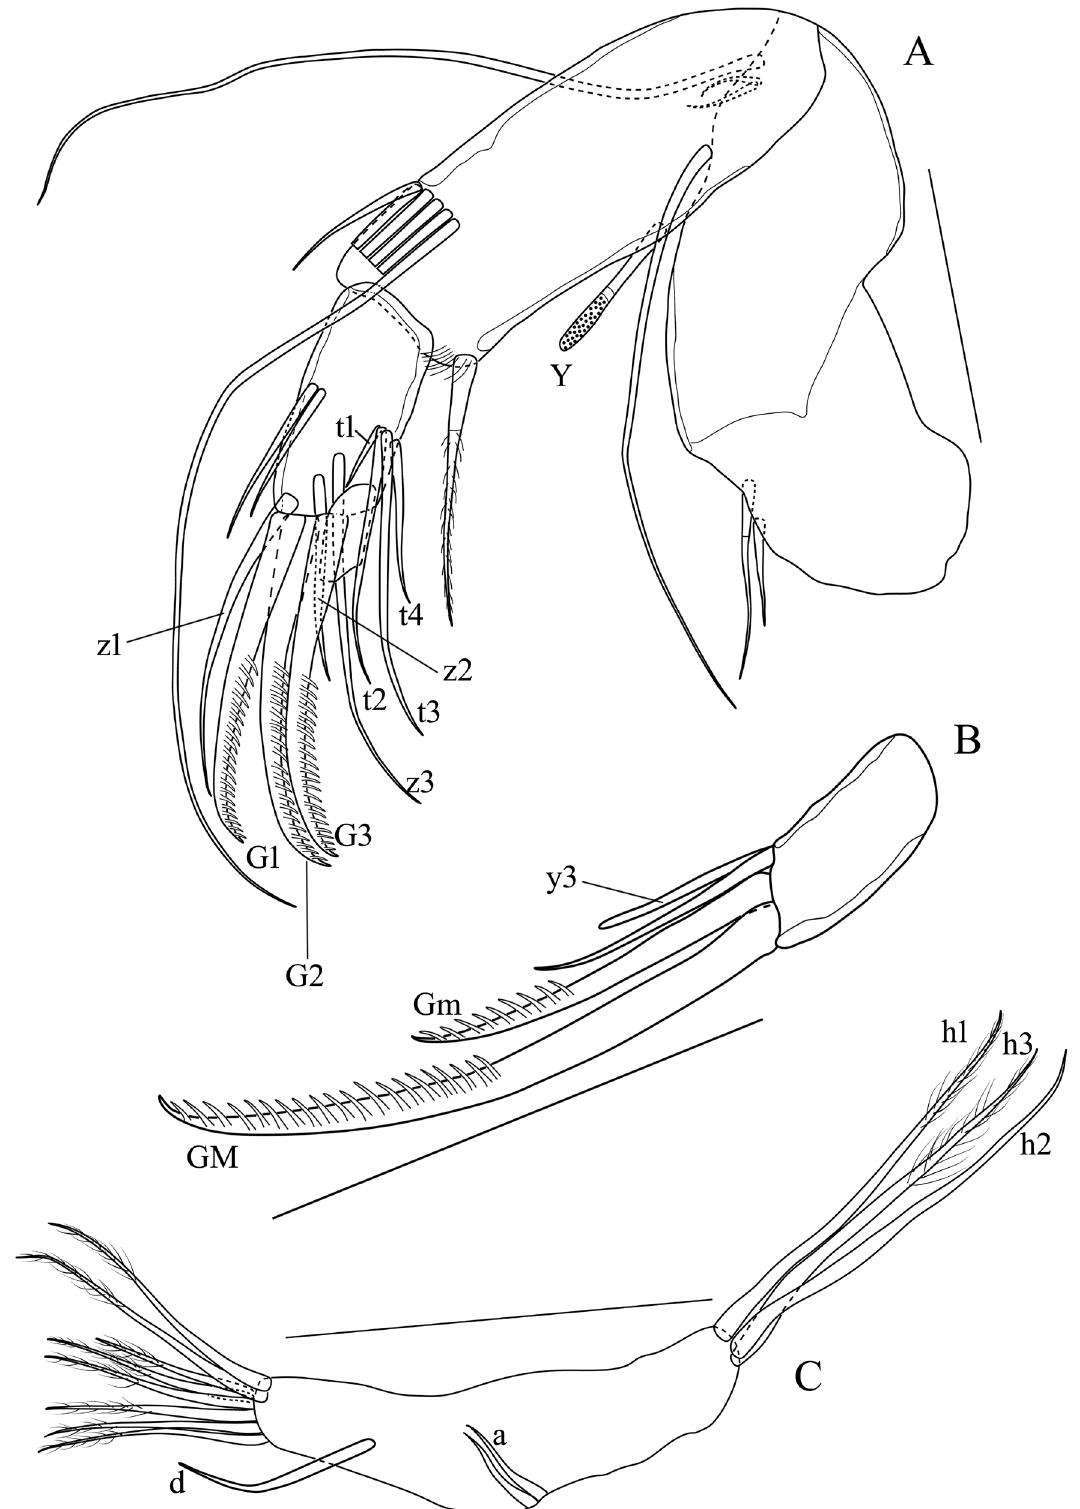
Fig. 9. Brasilodopsis baiabonita gen. et sp. nov. from Bonito, State of Mato Grosso do Sul, ♀. A . A2, without the terminal segment (MZUSP 41832). B . A2, terminal segment (MZUSP 41832). C . T1 (MZUSP 41826). Abbreviations: see text and Material and methods. Scale bars: 50